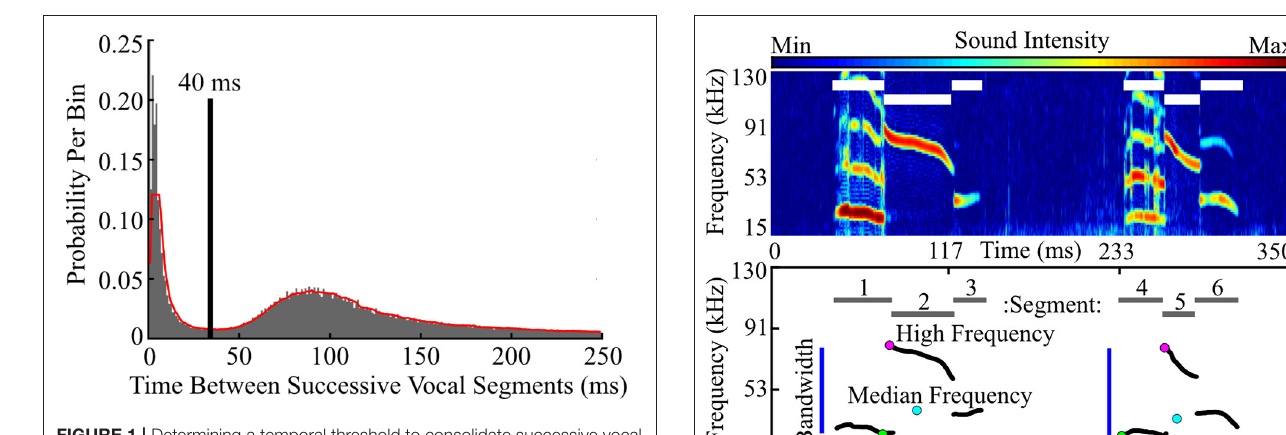
FIGURE 1 | Determining a temporal threshold to consolidate successive vocal segments into vocalizations. To determine the optimal interval for collapsing successive vocal segments into vocalizations, a histogram of the time between all pairs of successive vocal segments (gray) was generated, smoothed (red trace), and the first local minimum (black line) was used as the consolidation threshold. Consecutive segments separated by 40ms or less were subsequently consolidated into a single vocalization.